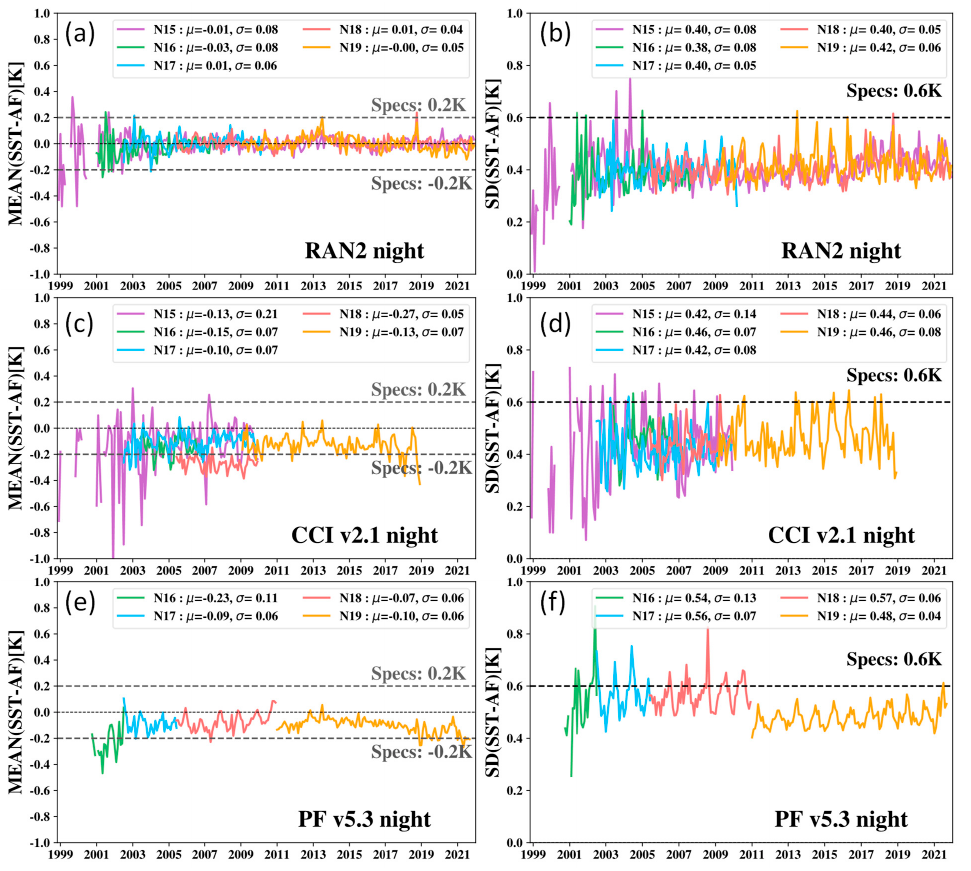
Figure 18. Time series of global monthly ( a , c , e ) biases and ( b , d , f ) SDs of ( a , b ) RAN2 ‘subskin’ SST, ( c , d ) CCI ‘skin’ SST + 0.17 K and ( e , f ) PF ‘skin’ SST +0.17 K with respect to AF. (Data are from the NOAA SQUAM system [21,22].)